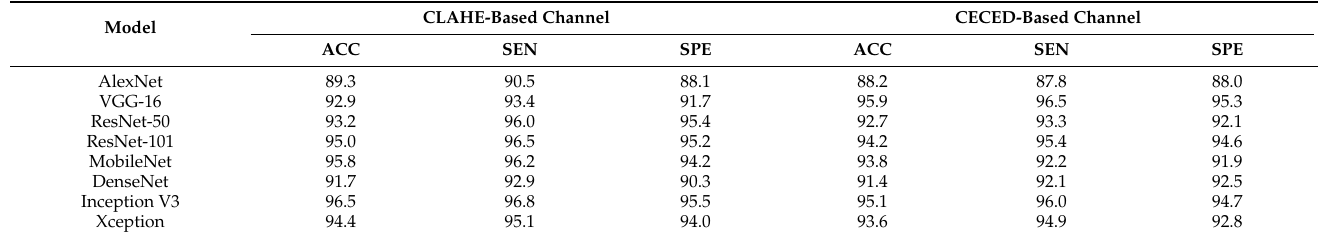
Table 7. Results obtained on the Kaggle dataset using different pre-trained models on our pro- posed